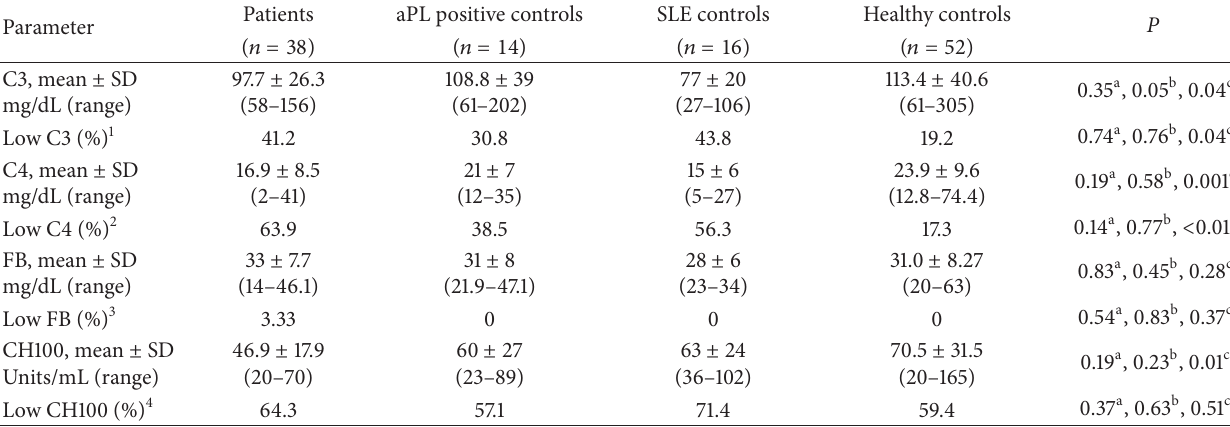
Table 2: Concentration and functional activity of complement proteins in patients with thrombotic APS and healthy controls.